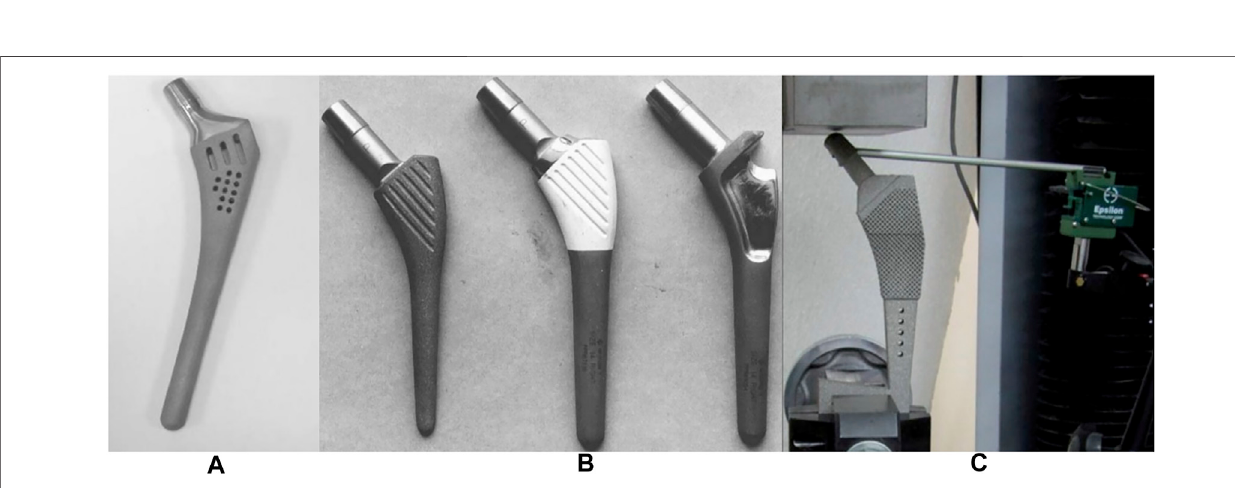
Frontiers in Bioengineering and Biotechnology |